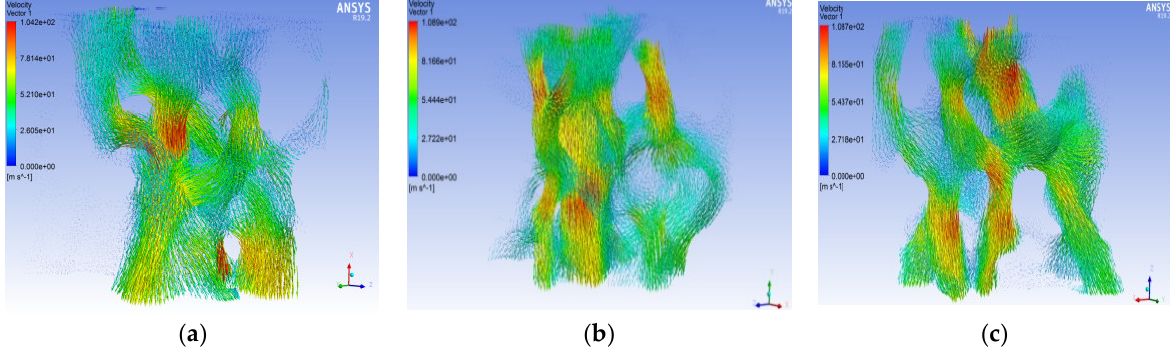
Figure 12. X, Y, and Z positive single channel seepage velocity distribution vector diagram. ( a ) X positive direction, ( b ) Y positive direction, and ( c ) Z positive direction.